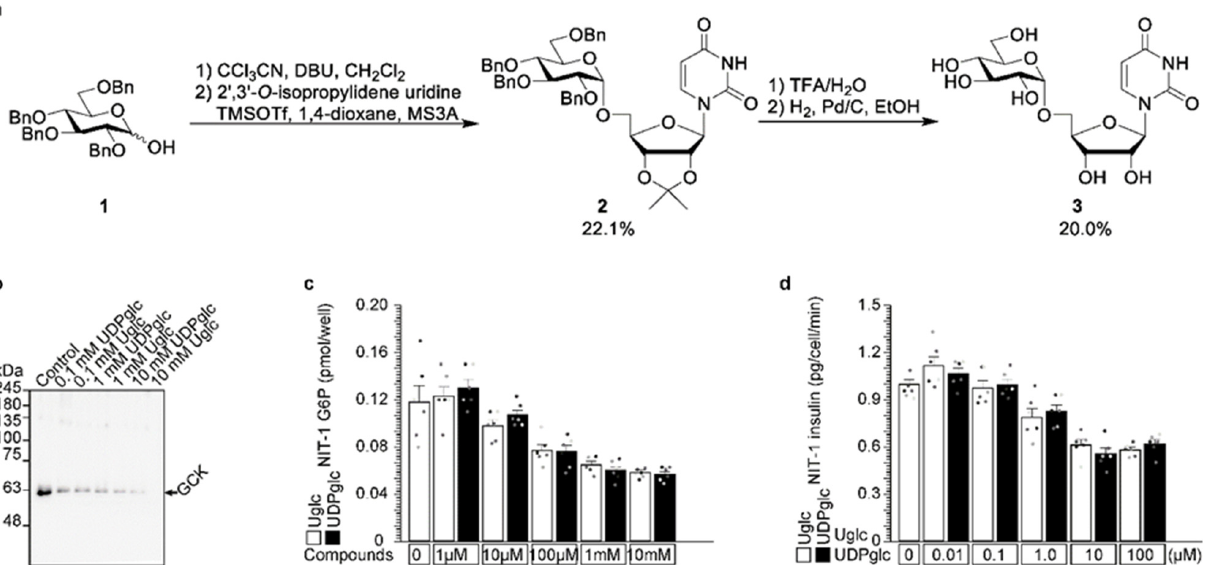
Figure 5. Uridine-glucose degraded glucokinase and reduced insulin secretion. ( a ) Uridine-glucose synthesis is described in the Materials and Methods. ( b – d ) Both uridine-glucose and UDP-glucose degraded glucokinase ( b ) and reduced G6P production ( c ) and insulin secretion ( d ) similarly. The values are reported as the means ± standard error (n = 6) with six individual data points ( c , d ).